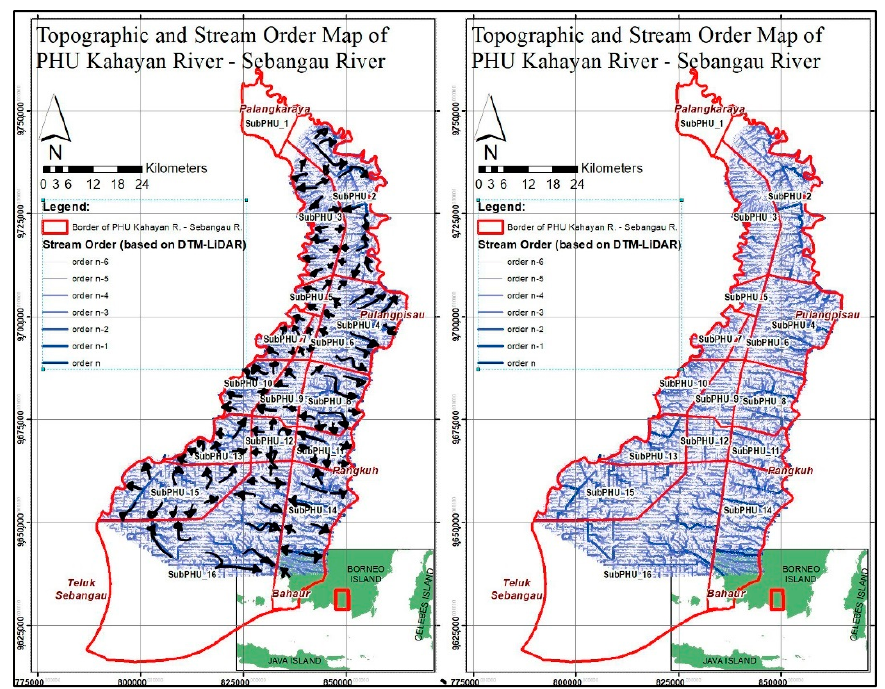
Figure 3. The radial streamline pattern (black arrows) leading to the outlet canal in determining the boundaries of the sub-PHU, as well as the resulting sub-PHU boundaries (red lines) in the Kahayan–Sebangau